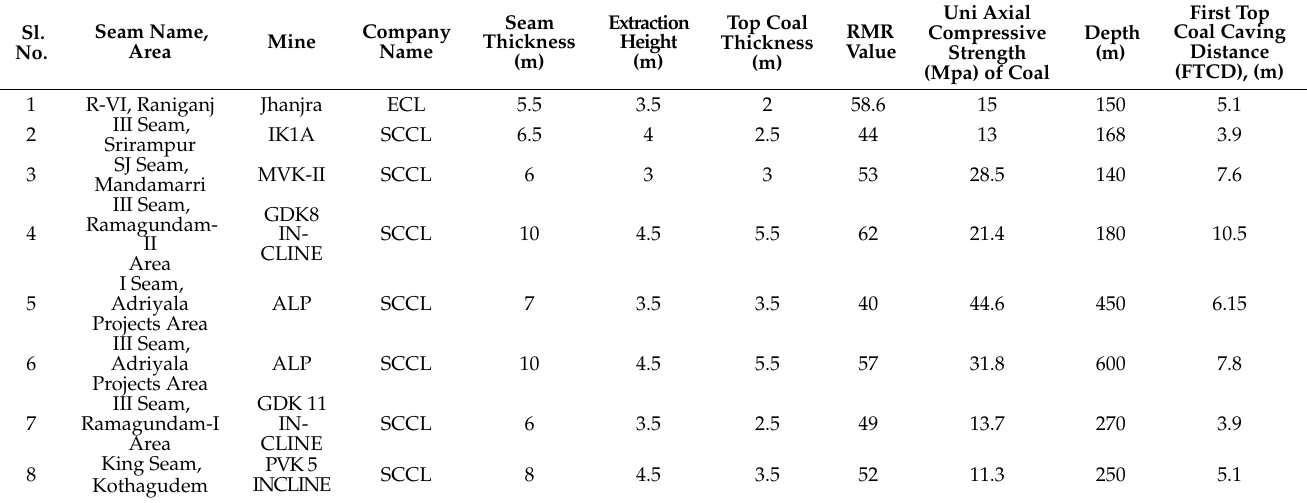
Table 7. FTCD of various coal mines in India.